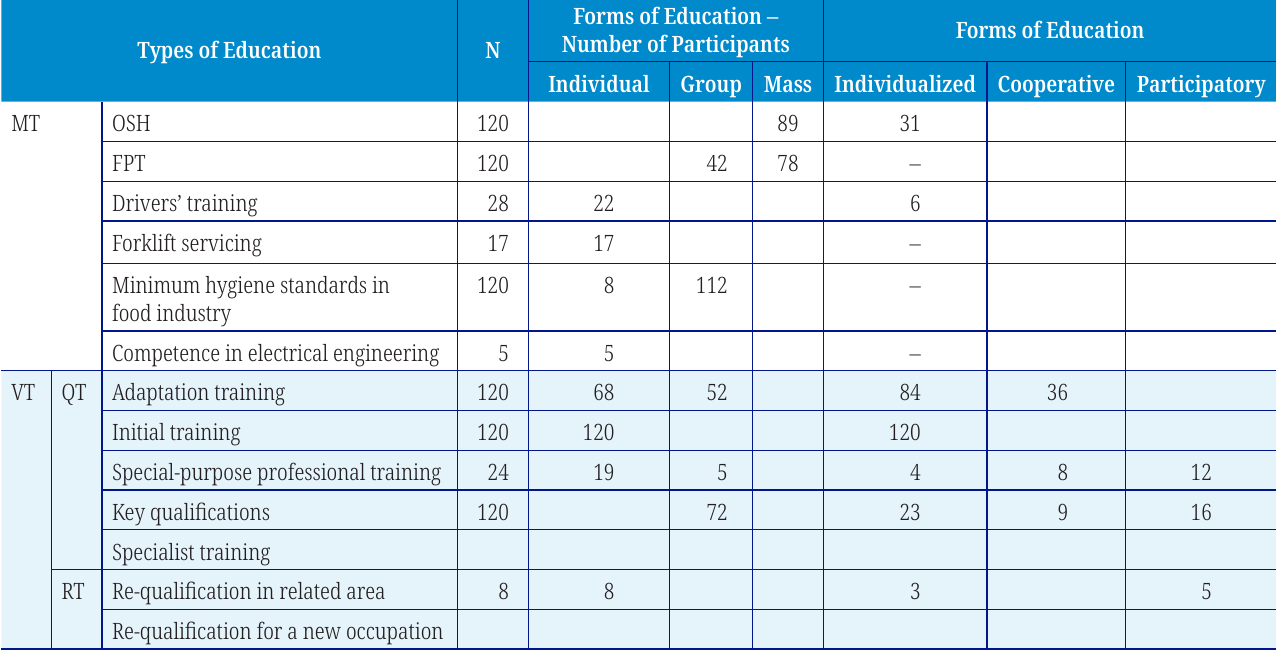
Table 1. Types of training activities in on-the-job